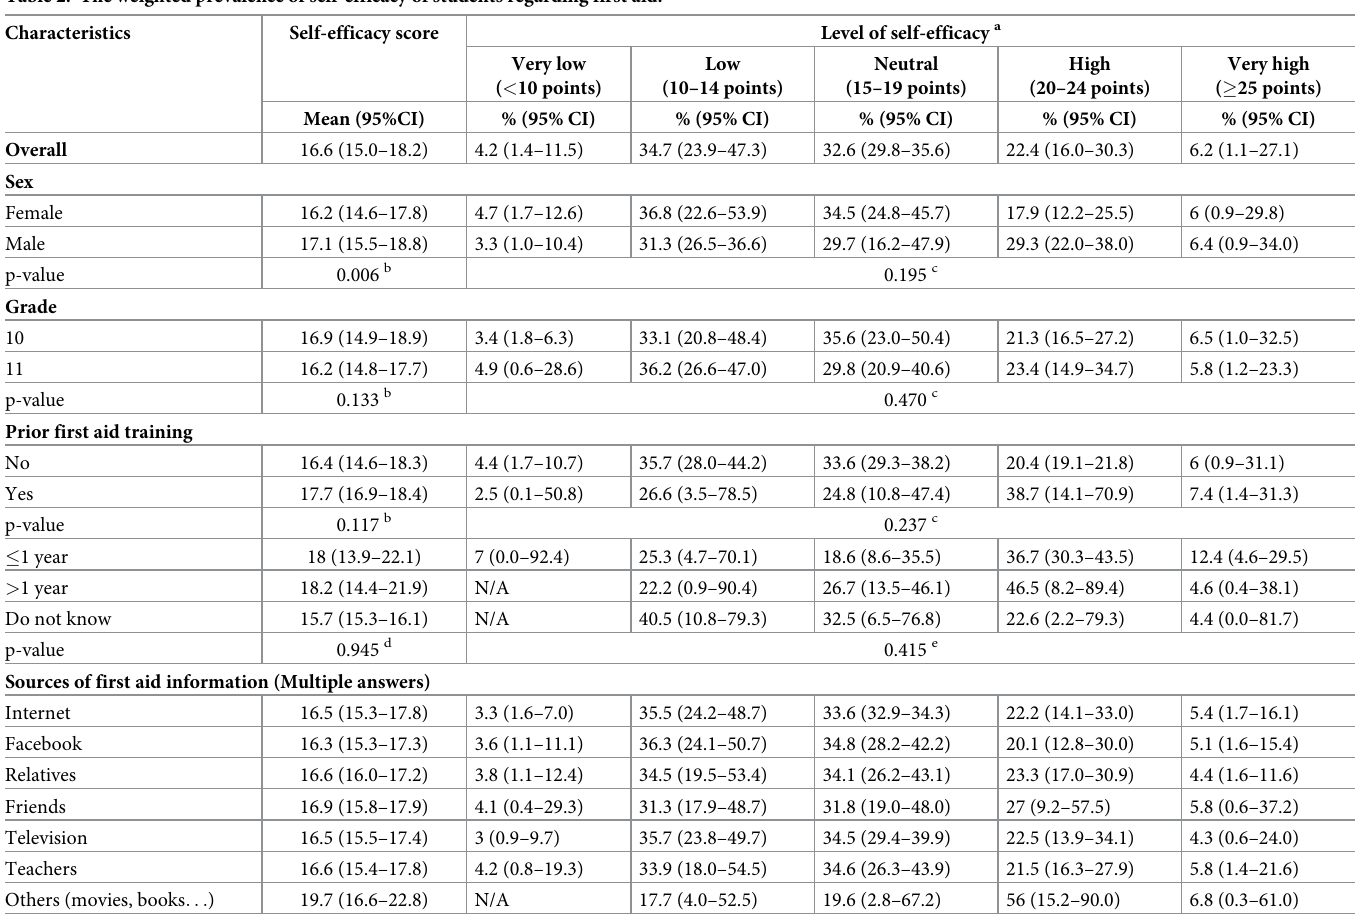
Table 2. The weighted prevalence of self-efficacy of students regarding first aid.